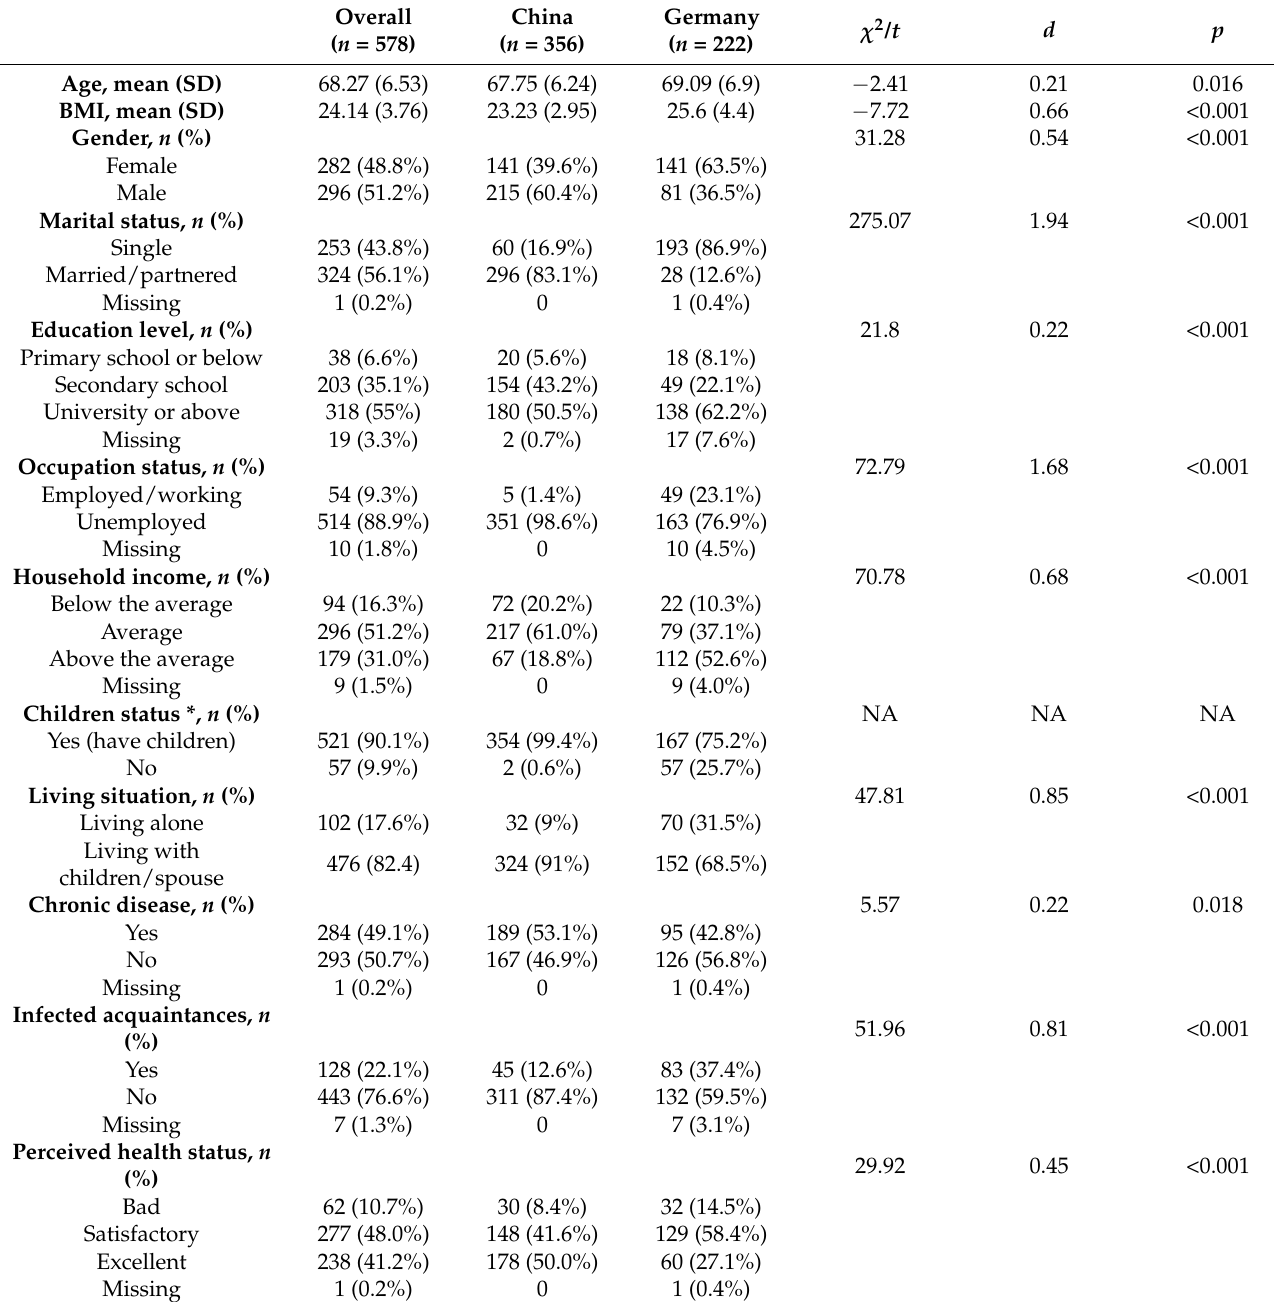
Table 1. Characteristics of overall sample and by